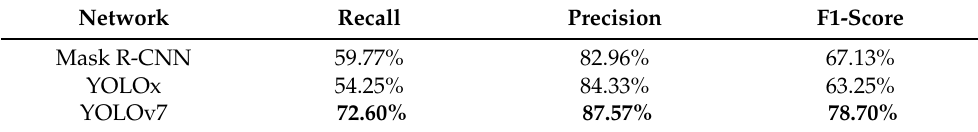
Table 2 lists the memory size and computation of each model. The GFLOPS provide a platform-independent metric for measuring the computational efficiency of a model. The size of the model was calculated as the total number of parameters with